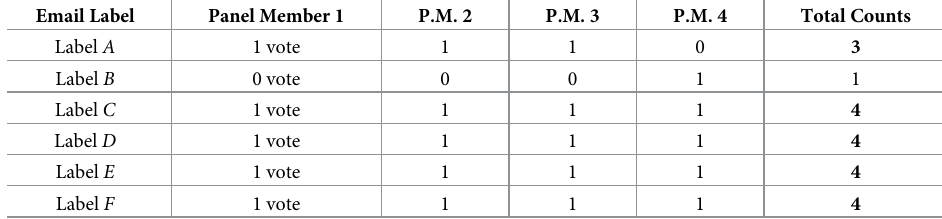
Table 1. Example instance of keyword label consolidation by the Delphi leader before instituting the Delphi process. Email